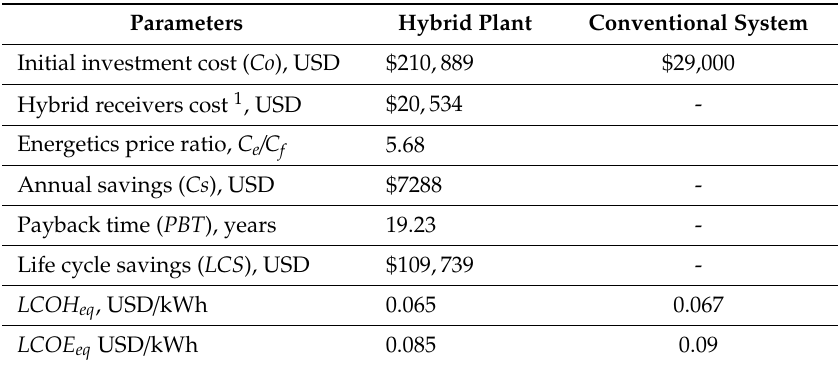
Table 3. Economic metrics of the hybrid plant and conventional system, respectively (Source: Author’s own calculation).